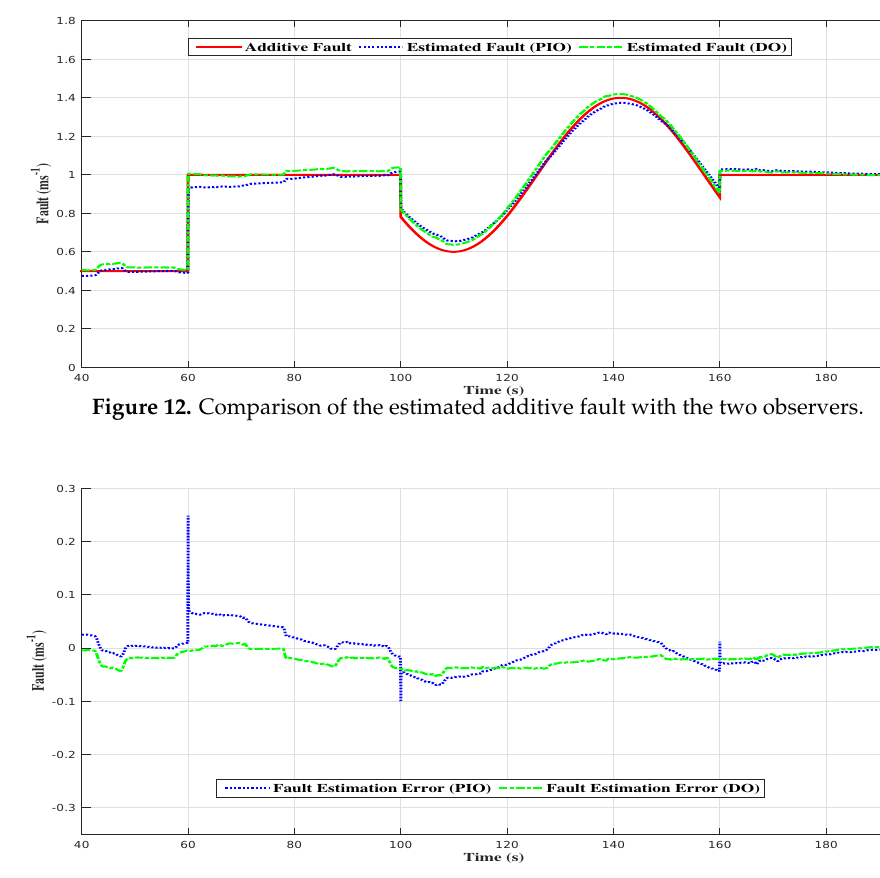
Figure 13. Comparison of fault estimation error between the two